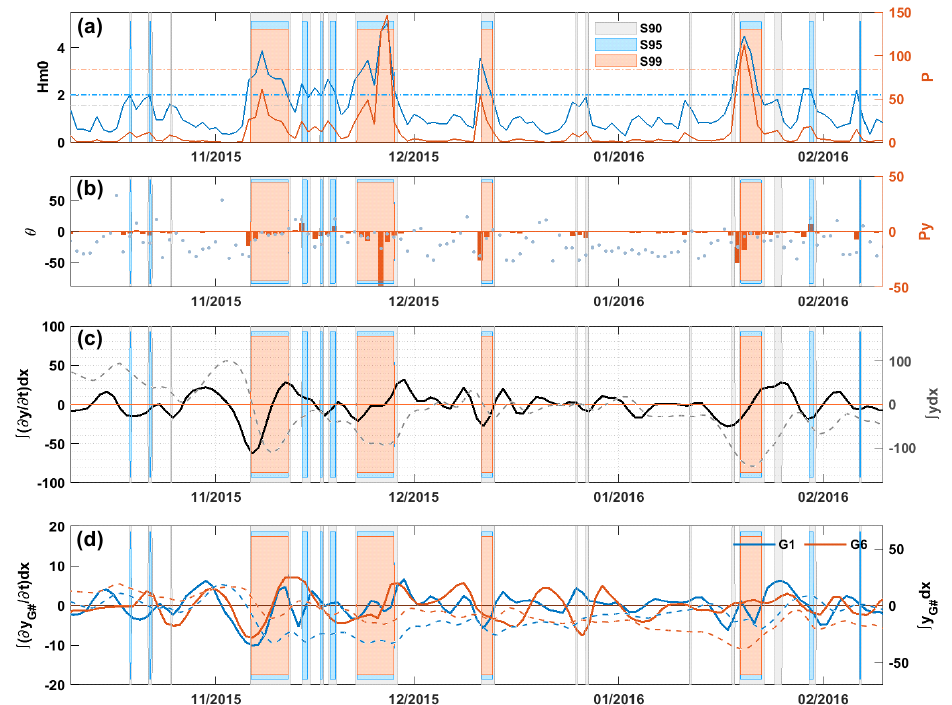
Figure 7. Changes in wave characteristics and beach width during the winter between 2015 and 2016. ( a ) Significant wave height and wave power, ( b ) wave direction and longshore component of wave power, ( c ) longshore transport rate (solid line) and integrated beach width (dashed line), and ( d ) longshore transport rate (solid line) and integrated beach width for sectors G1 and G6 (dashed line). (cid:82) ∂ y / ∂ tdx , is also presented in Figure 6e. This quantity The integral of the rate ∂ y / ∂ t along the coast, is related to the time variation of LST, Q x , as described by one-line theory in Equation (2). It